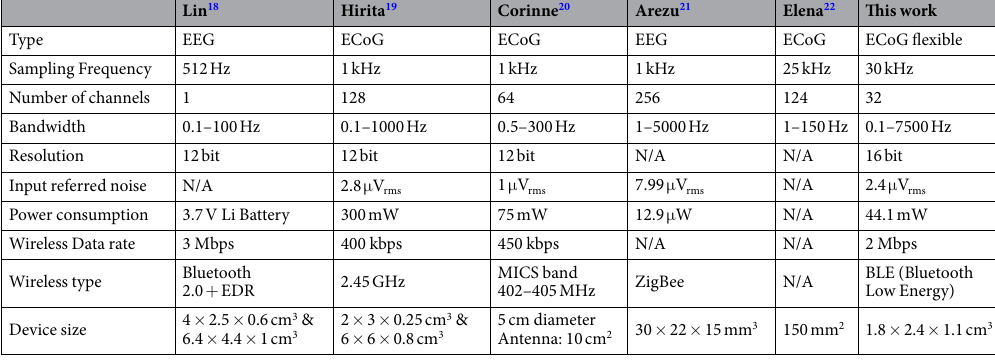
Table 1. Comparison of our system and other BCI